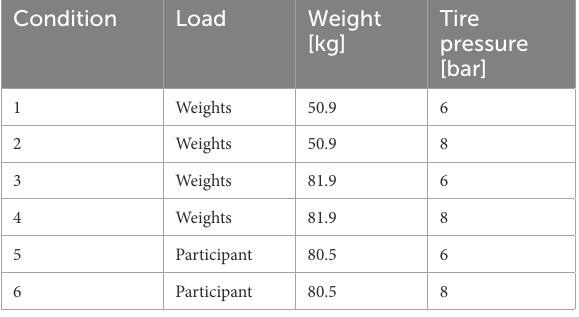
TABLE 2 Mean of measured speed of both treadmills (A,